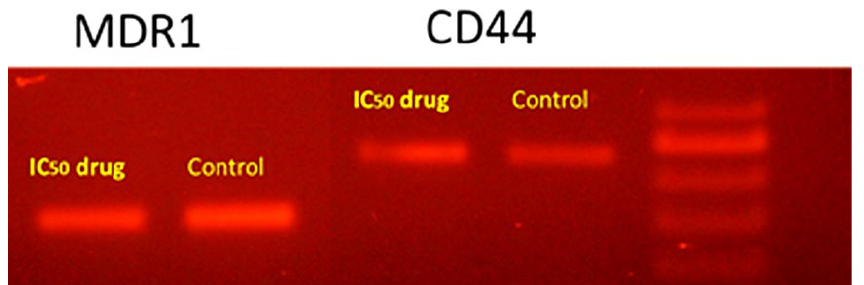
Figure 4. Fragmentation analysis of DNA specifying the noticeable effects of Rumex vesicarius in prompting a DNA laddering effect as a marker of cell apoptosis. Characterization of the MDR1 and CD44 antibodies as a target of R. vesicarius- dependent apoptosis.